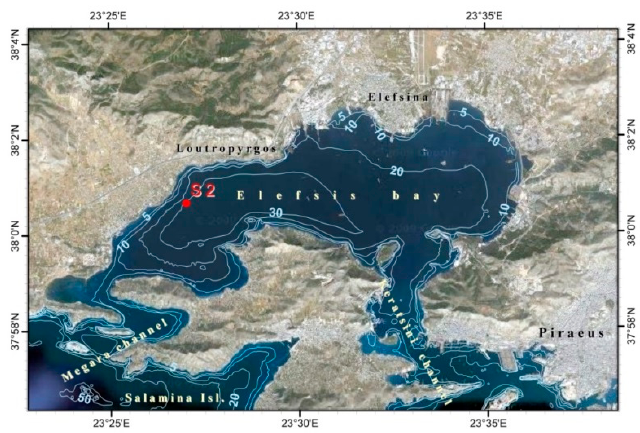
Figure 1. Bathymetric map of Elefsis Bay (Saronikos Gulf, Eastern Mediterranean Sea). The location of the sampling site is also shown [28].